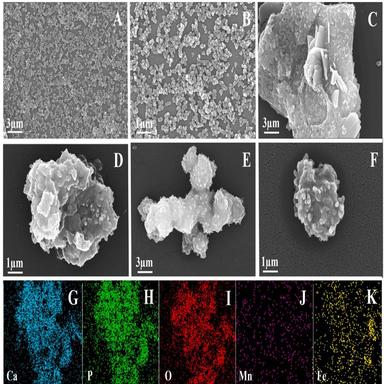
FE-SEM images of (A, B) MnFe2O4 Nanoparticles, (C, D) HAp Bulk-sheets, (E, F) Core-Shell MnFe2O4/HAps and EDX mapping analysis of (G) Ca, (H) P, (I) O, (J) Mn and (K) Fe.